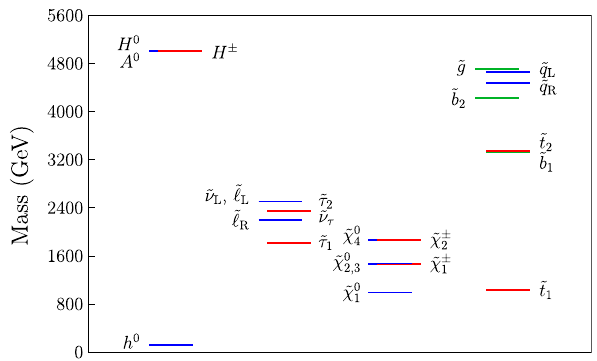
Fig. 7 Sparticle mass spectrum of the NUHM1 best-fit point